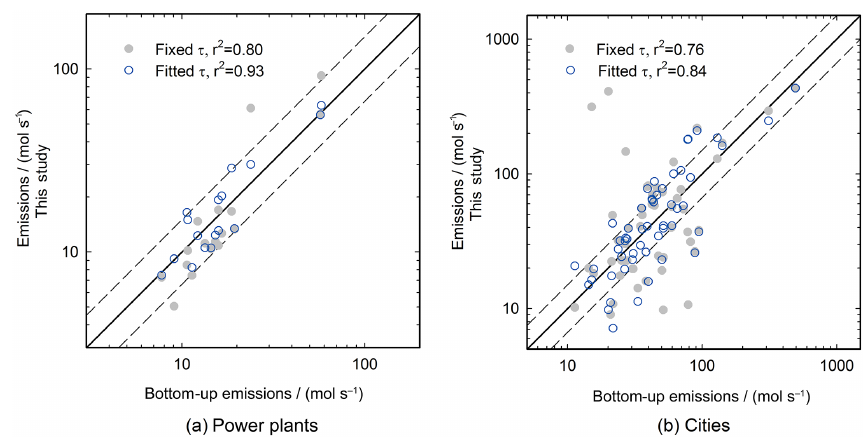
Figure 9. Scatter plots of the resulting NO x emissions for the investigated power plants and cities using fitted lifetimes (open circles) and fixed lifetimes (3.7h) (filled circles) versus the respective estimates from bottom-up emission inventories. Emissions are given in molec/s calculated assuming a constant emission rate. The straight and dashed lines represent the ratio of 1 : 1 and 1 . 5 : 1 / 1 : 1 . 5,